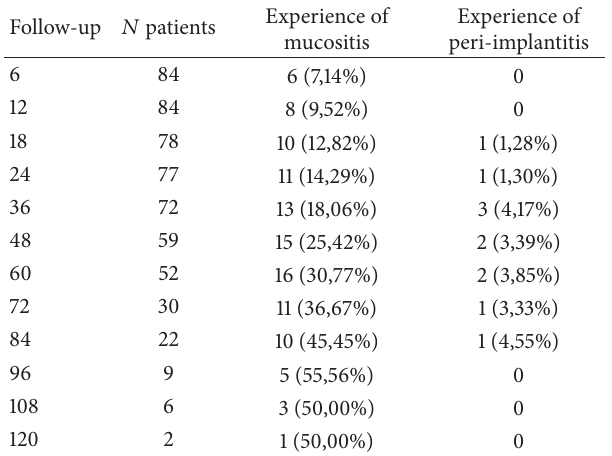
Table 7: Implant-related experience of peri-implant mucositis and peri-implantitis